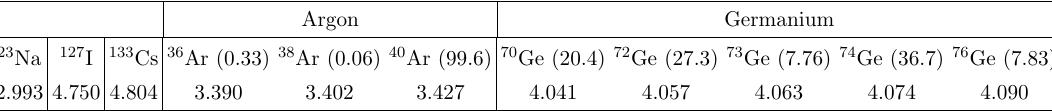
Table 4 . Proton rms radius (in fm) of the stable isotopes of sodium, iodine, cesium, argon and germanium [83]. Their percentage relative abundance is provided in parenthesis. For detectors made of argon and germanium, we use the average h R p i = P the relative abundance and proton rms radius of the i -th isotope,